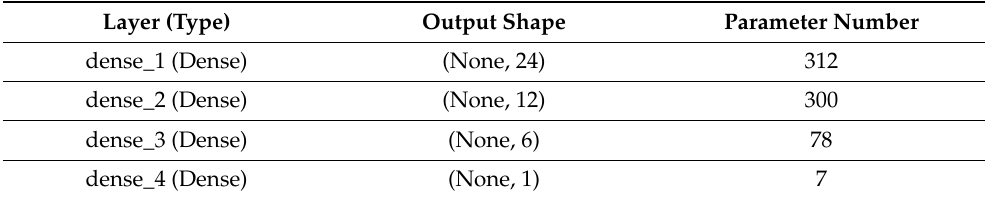
Table 1. The structure of the dense neural network.